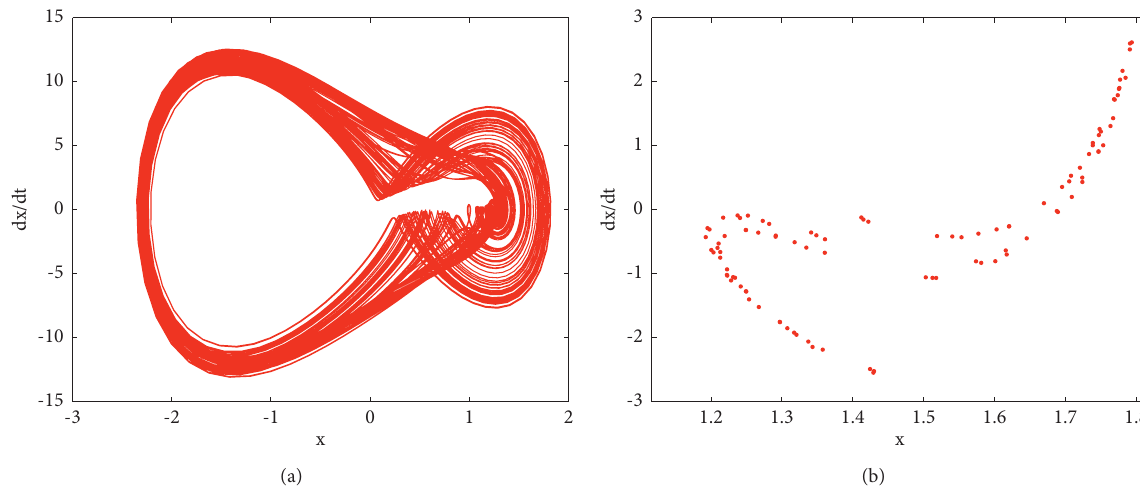
Figure 4: Phase portrait, time history, and Poincar´e cross section diagram of the system at F � 74.30 and τ � 1.2. (a) Phase portrait. (b) Poincar´e cross section diagram ( c � 0.5, c 1 � 30, c 2 � 20, μ � 0.001, k 1 � 10, and ω � 3.9).